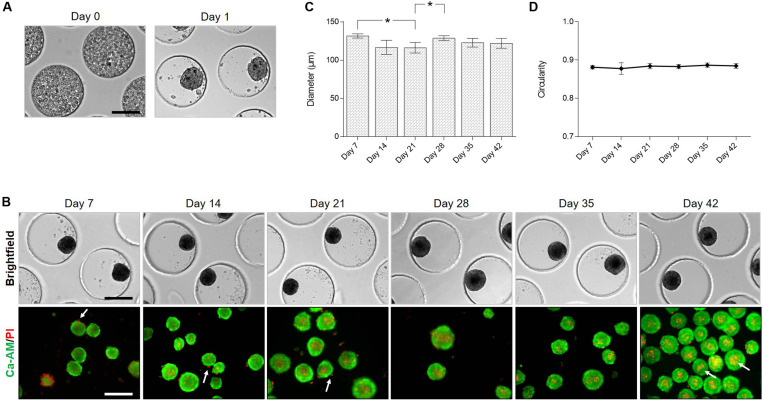
Formation of cartilage microtissues: morphology and viability. (A) hBM-MSC lowered spontaneously into the pores of the microwell. After 1 day of culture irregular shaped spheroids were formed. (B) Light microscopy and live/dead staining of spheroids over time in culture, white arrows indicate dead cells. (C) Evaluation of spheroid diameter and (D) circularity (n = 3, Welch’s ANOVA test followed by a post hoc Games-Howell, significant differences were marked as *p < 0.05). All data are presented as mean ± 95% CI. All scale bars represent 200 μm.